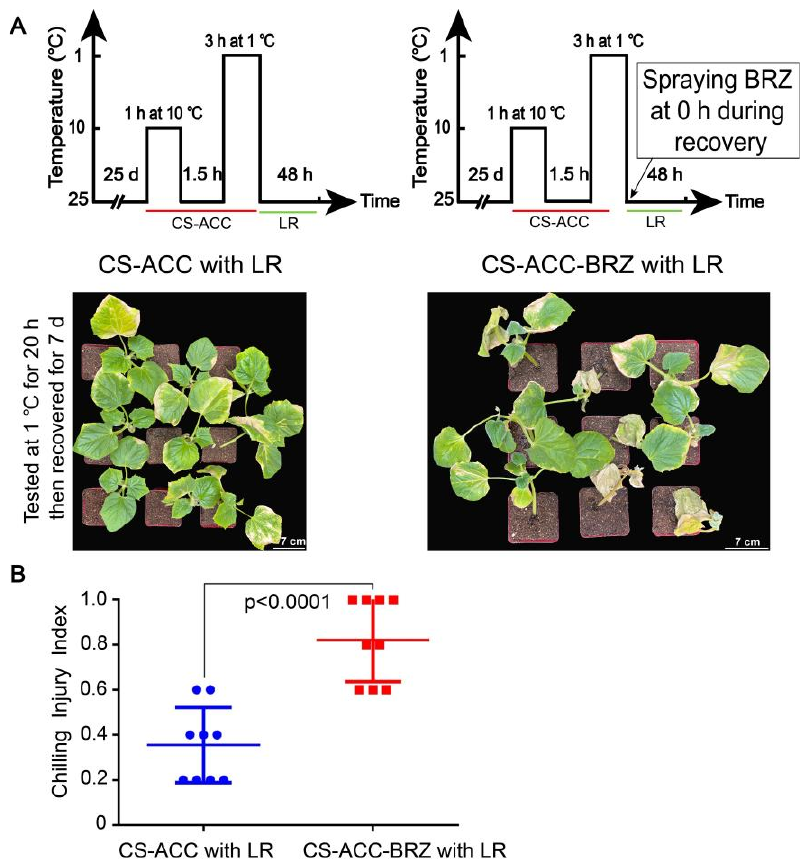
Figure 9. The cold tolerance ( A ) and CII ( B ) of cucumber seedlings tested by a tester cold stress (1 °C, 20 h) following 48 h of recovery after CS-ACC or CS-ACC-BRZ, and then placed in recovery for a period (25 °C/18 °C, day/night, 7 days). ( A ): a schematic diagram and cold tolerance of CS-ACC with LR and CS-ACC-BRZ with LR. CS-ACC: cucumber seedlings were treated with a cold stress regime of 10 °C for 1 h, 25 °C for 1.5 h, and 1 °C for 3 h; CS-ACC-BRZ: BRZ was sprayed onto the seedlings during recovery after CS-ACC. ( B ): CII of cucumber seedlings. CS-ACC: cold stress acclimation; LR: long recovery, 25 °C. The different letters indicate significant differences as assessed by the Turkey HSD test ( p < 0.05; n = 9).